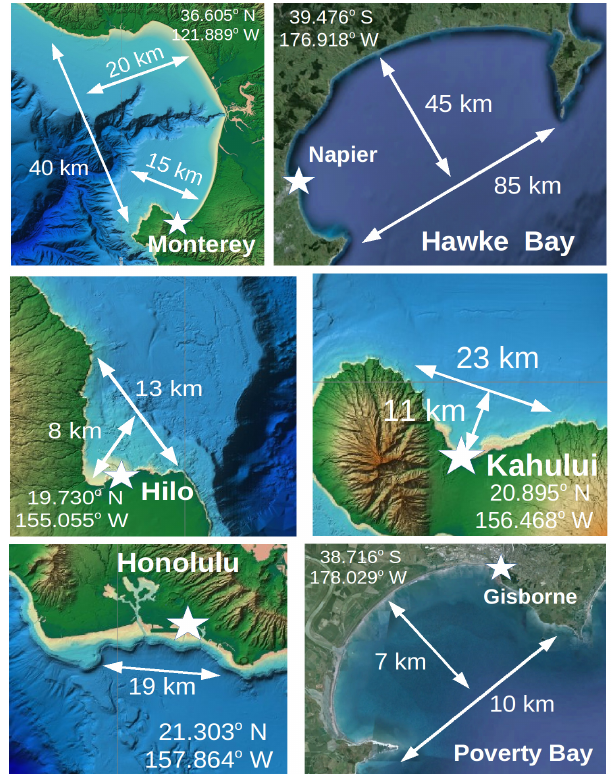
Figure 1. Location and approximate dimensions of bays. Tide gauge locations are marked with a star and denoted by latitude and longitude. Table 1. Tidal ranges at the six tide gauges. GT is the great diur- nal range (difference between mean higher high water and mean lower low water) and MN the mean range of tide (difference be- tween mean high water and mean low